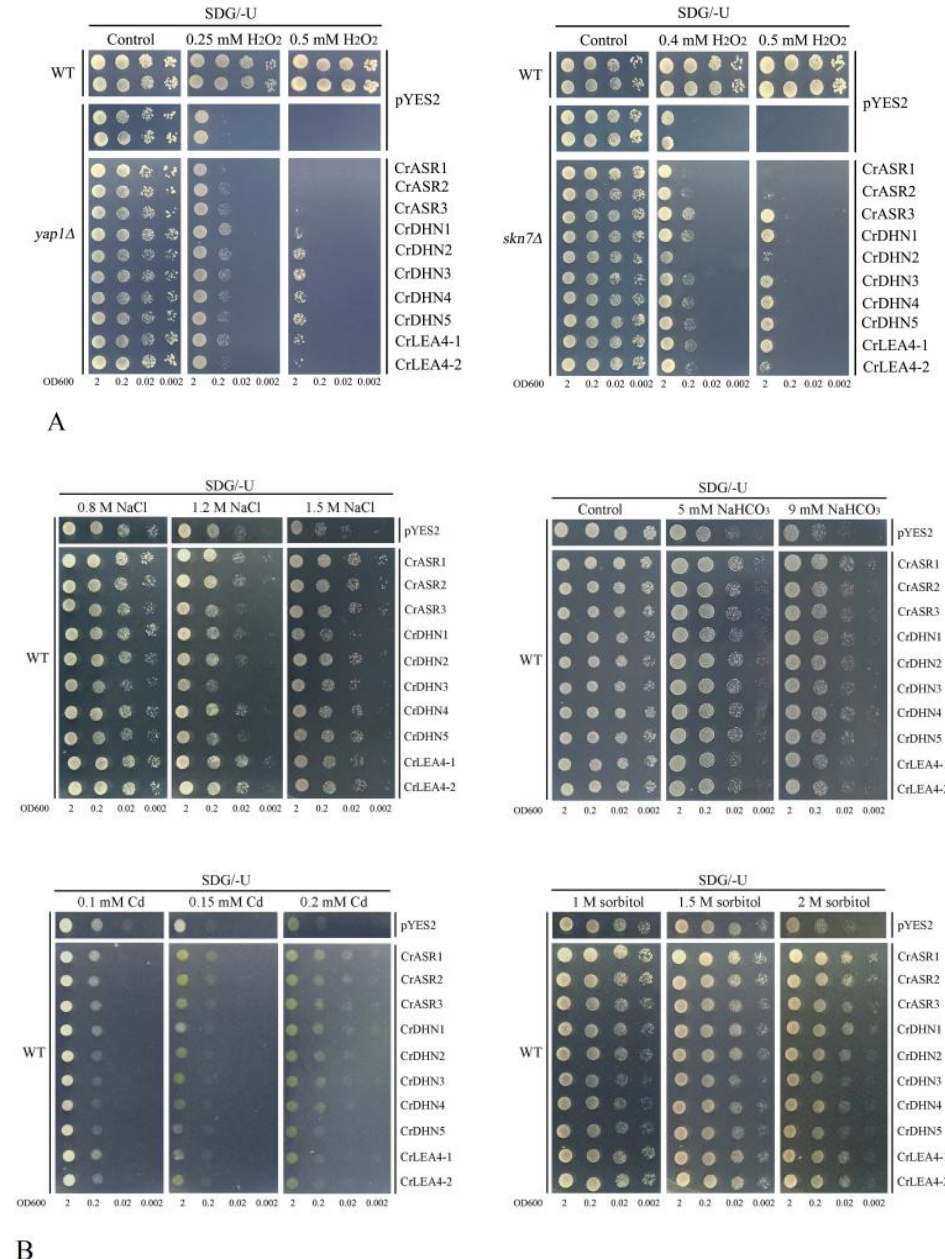
Figure 8. The tolerance confirmations of the 3 CrASR s, 5 CrDHN s, and 2 CrLEA_4 s heteroexpression in yeast. ( A ) H 2 O 2 oxidative stress tolerance confirmations in yeast. ( B ) Salt, alkaline, cadmium, and high osmotic tolerance confirmations in yeast. The stress factors with different concentrations were showed in